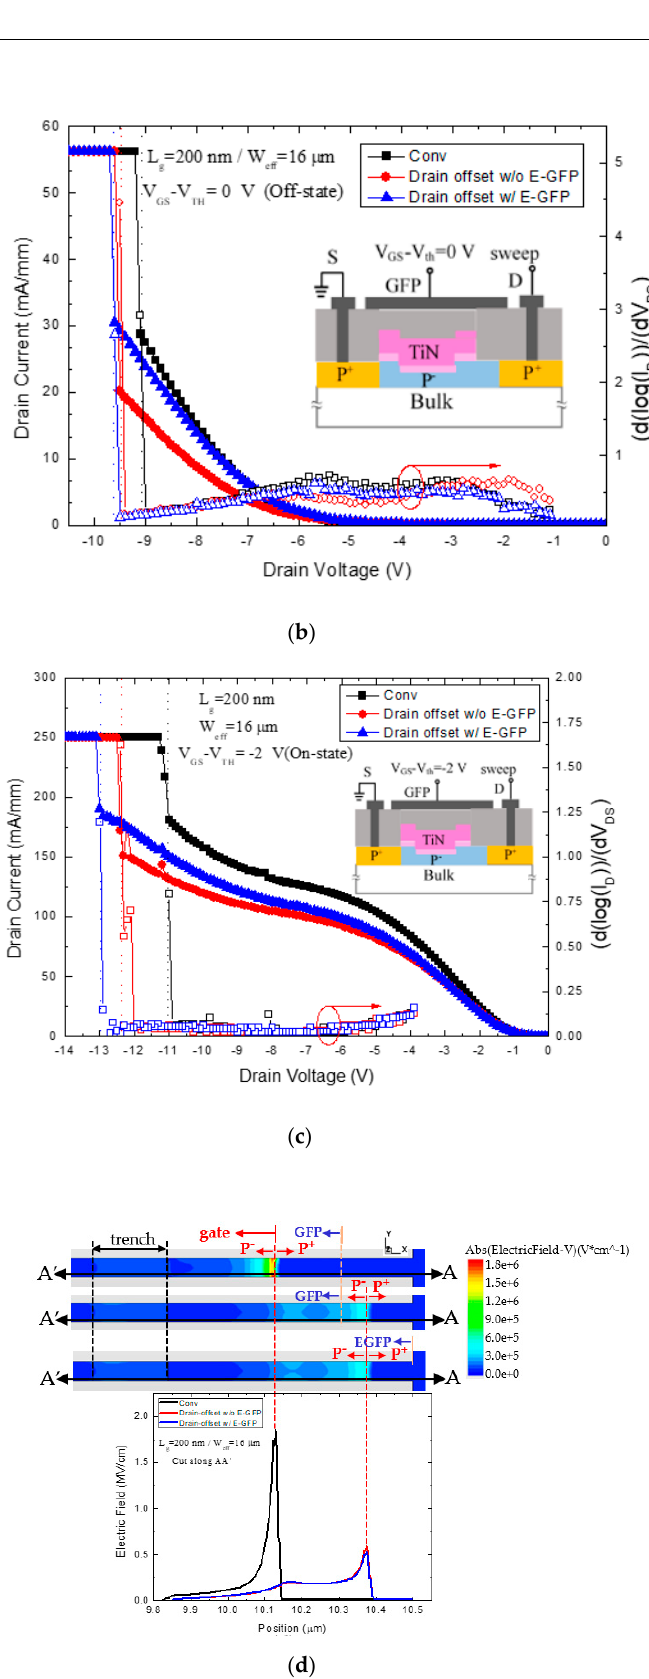
Figure 5. ( a ) Off-state and on − state breakdown voltage, and specific − on resistance of JL FinTFTs. Output characteristics and extraction of breakdown voltage by the derivative method for JL FinTFTs at ( b ) off − state and ( c ) on − state. ( d ) Surface electric field distribution of JL FinTFTs before break- down.